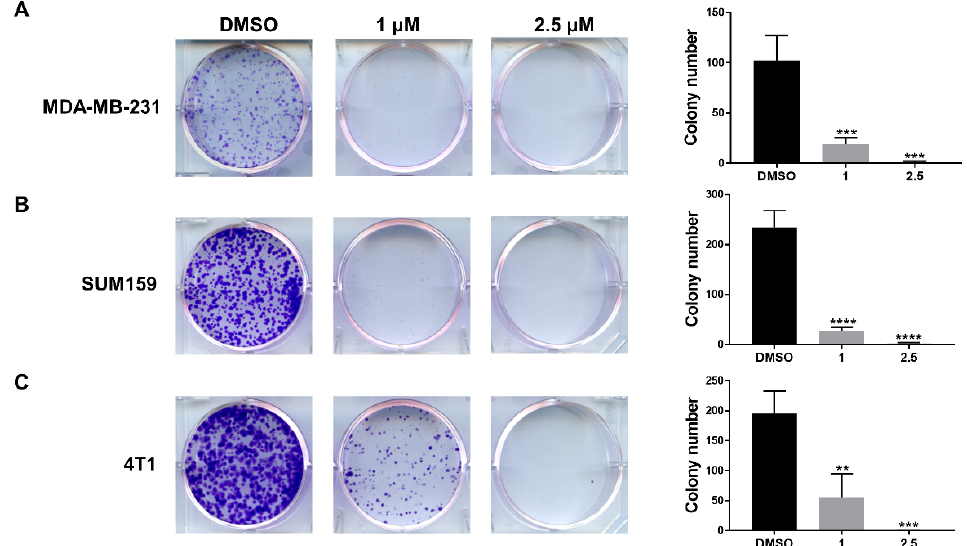
Figure 4. LLL12B suppressed colony formation of TNBC cells. MDA-MB-231 ( A ), SUM159 ( B ), and 4T1 ( C ) cells were seeded in a 6-well plate and treated with DMSO or LLL12B for 24 h and recovered in a drug-free culture medium for 7 days. Representative images of colony formation are shown in the left panel and the colony number was quantified and is shown in the right panel. ** p < 0.01, *** p < 0.001 and **** p < 0.0001.